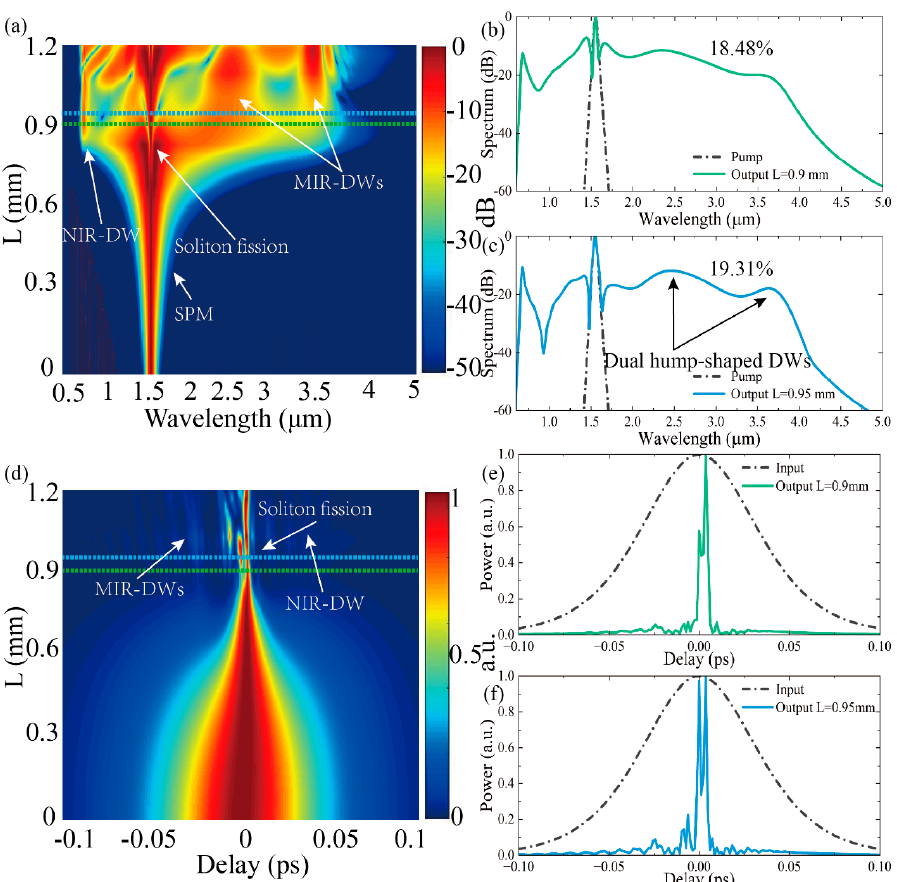
Figure 3. ( a ) Spectral evolution along the propagation length with the full-width at half maxima τ FWHM = 75 fs. ( b ) The spectra of the pump and the output at L = 0.9 mm. ( c ) The spectra of the pump and the output at L = 0.95 mm. ( d ) Temporal evolution along the propagation length with the full- width at half maxima τ FWHM = 75 fs. ( e ) The normalized temporal pulse envelopes at input and out- put at L = 0.9 mm. ( f ) The normalized temporal pulse envelopes at input and output at L = 0.95 mm. We further studied the influence on the MIR-DW generation when the pump condi- tion changes, i.e., the pulse width τ 0 and the coupled pulse energy. We can see the spectral and temporal evolution with the propagation length in Figure 4a,d when the full-width at half maxima τ FWHM is reduced to 50 fs. As the peak power P 0 is kept at 4.5 kW, the pulse